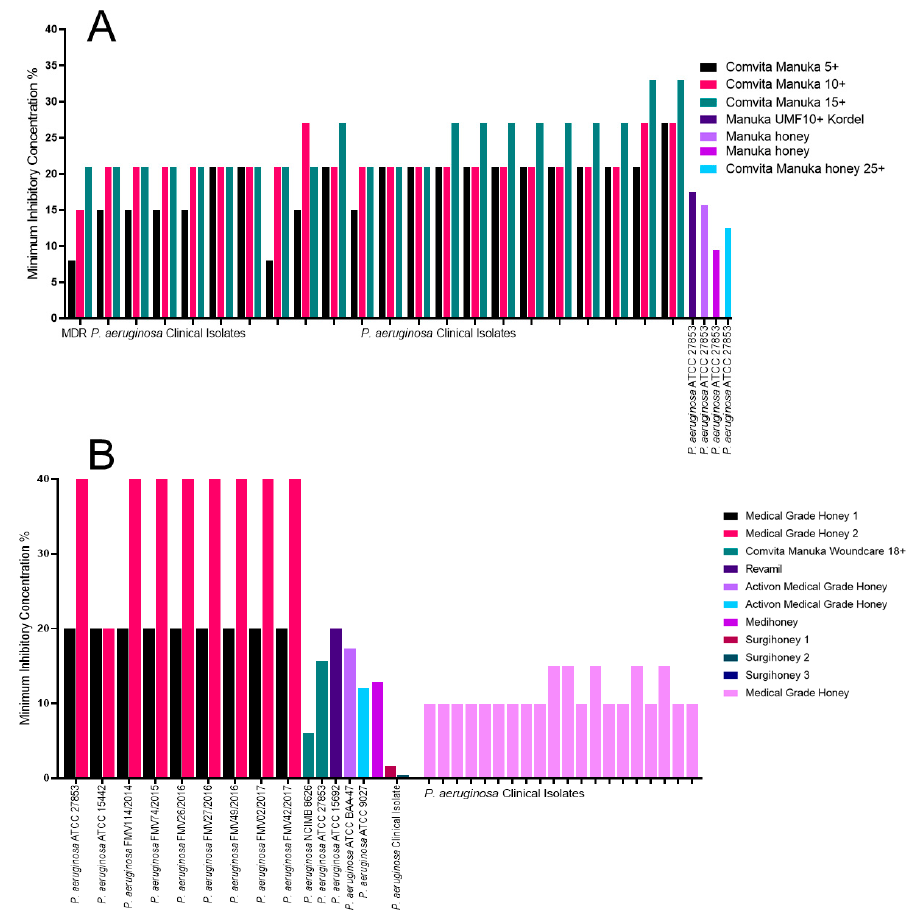
Figure 2. MICs of the P. aeruginosa isolates tested against a variety of Manuka and medical-grade honey. ( A ) All the Manuka honey MIC data used in this review, identifying the ungraded Manuka honey and Comvita Manuka UMF5+ as the most effective; and ( B ) all the medical-grade honey MIC data used in this review, identifying the three Surgihoneys as the most effective.